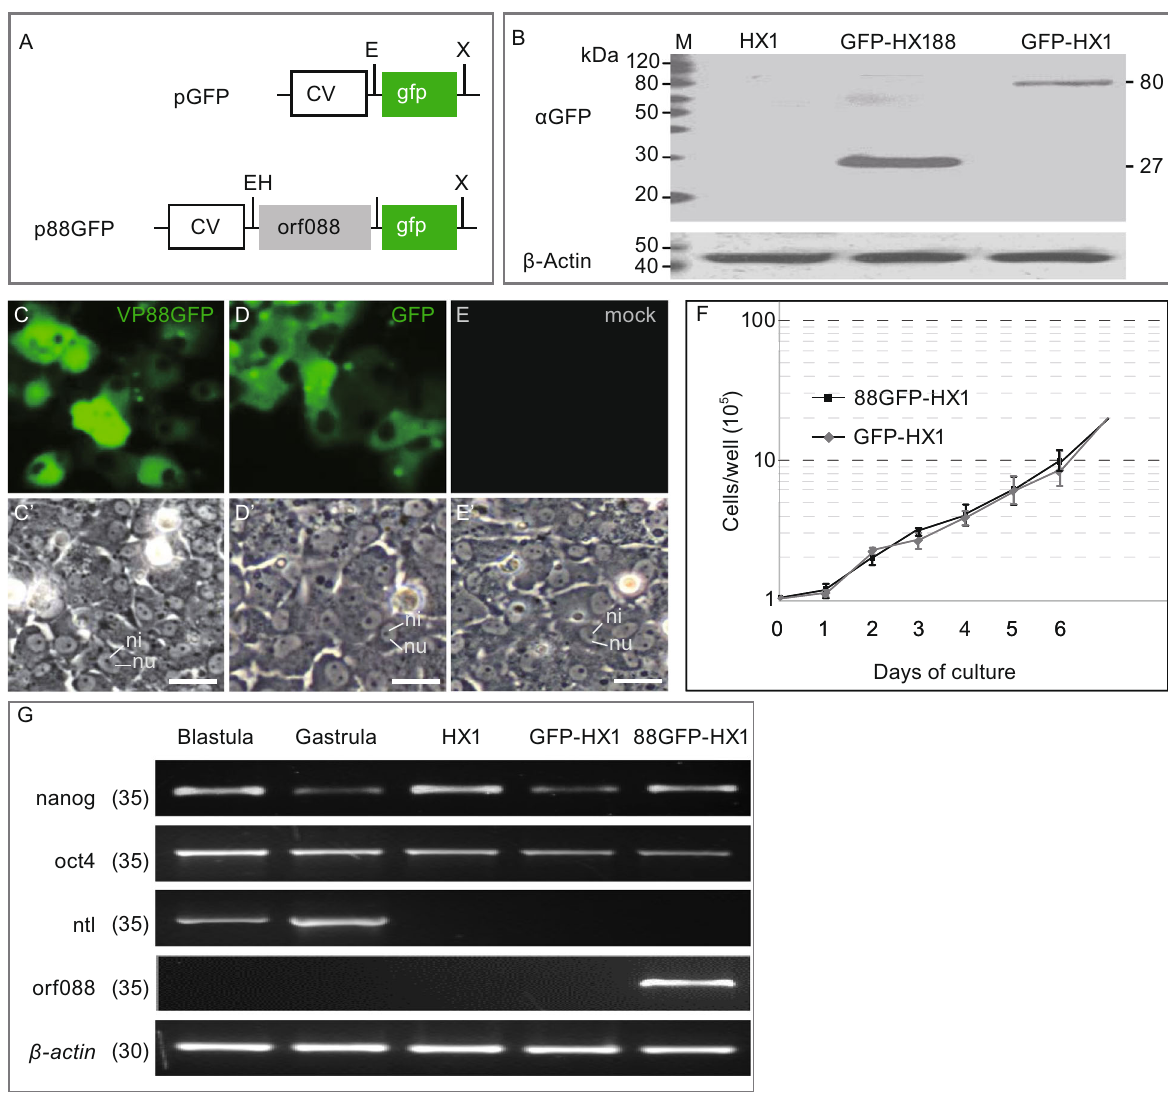
Figure 1. VP88GFP expression retains the ES cell properties. HX1 cells at 48 h post mock, pGFP and p88GFP transfection